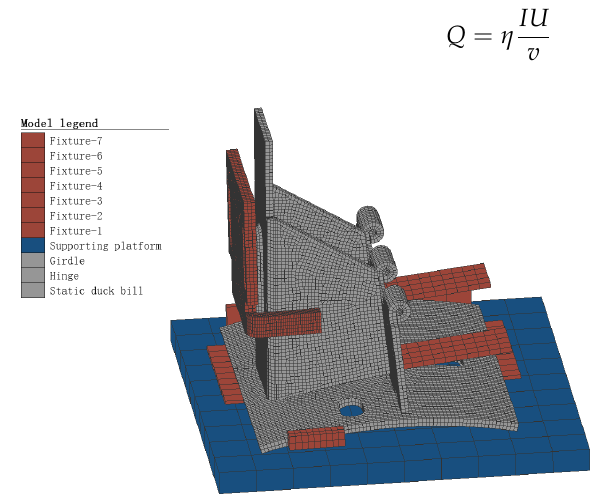
Figure 4. Meshing model of duckbill welding parts.